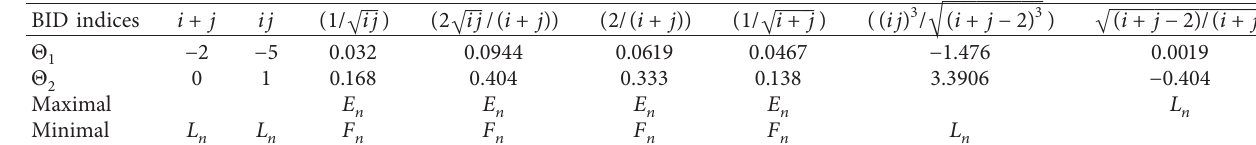
� odd and n � even. n for n and Θ for different BID 1 2